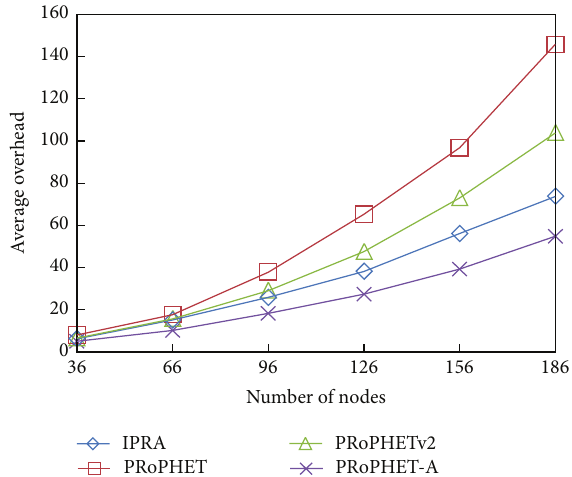
Figure 5: Average overhead (AO) versus number of nodes.